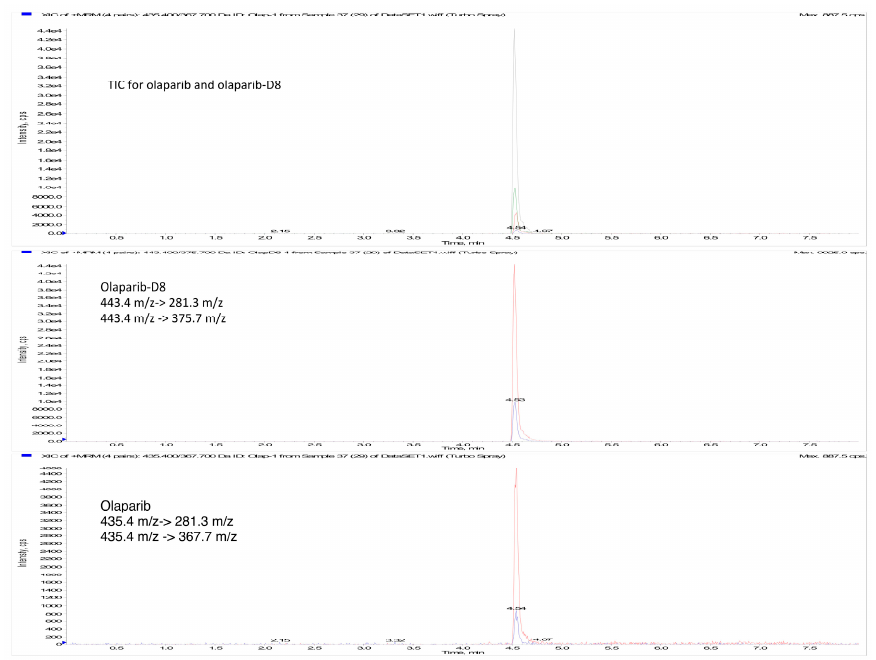
Figure 2. Representative chromatogram of cytoplasmic extract (0.2 ng/mL Ola). From the top: Total ion Chromatogram (MRM signals are overlayed), Ola-d8 extraction, and Ola extraction.